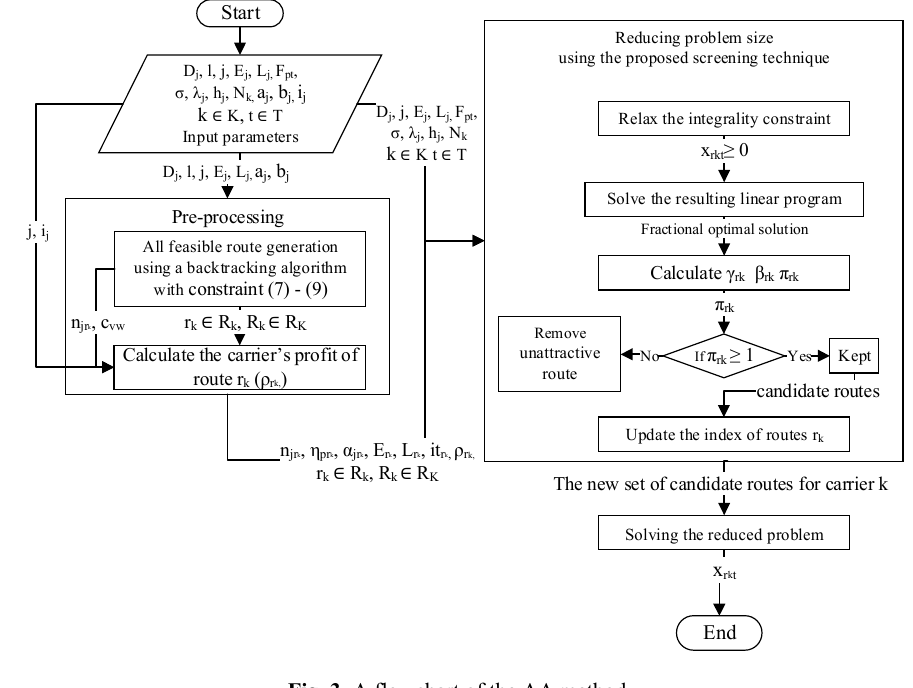
Fig. 3. A flowchart of the AA